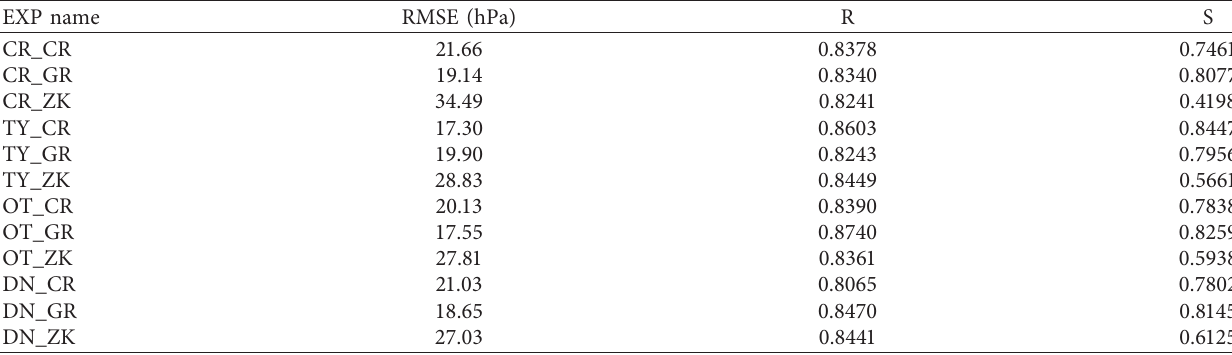
Table 3: Root mean square error (RMSE), Pearson correlation coefficient (R), and model skill (S) for MSLP from 12 experiments.